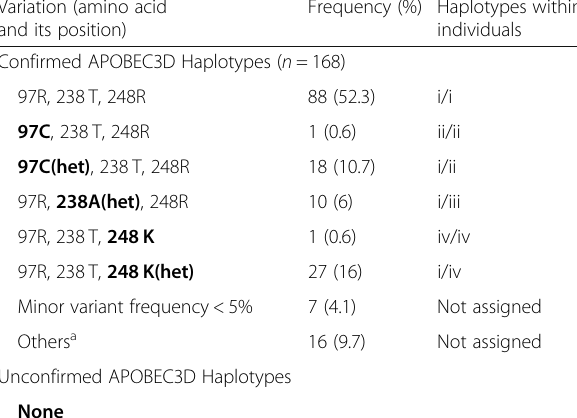
Table 3 Haplotypes frequencies for A3D, A3F, A3G and A3H (Continued)